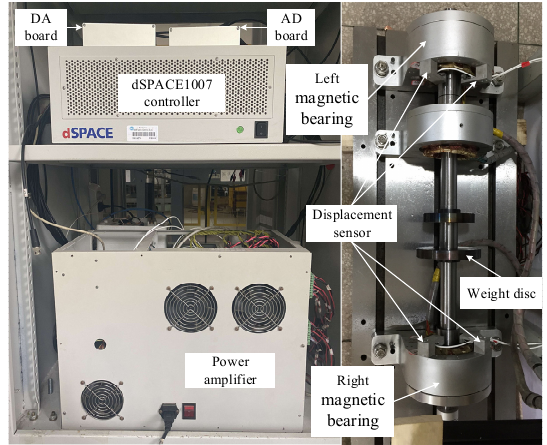
Figure 6. Experimental platform.